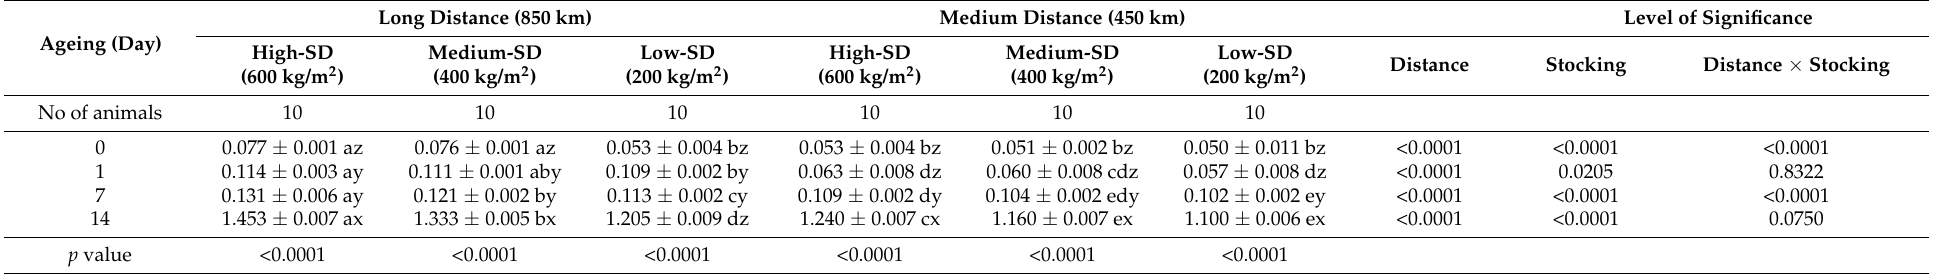
Table 4. Differences in the malondialdehyde content MDA (mg/kg) of Longissimus lumborum muscle during postmortem ageing periods in cattle subjected to different distances and stocking densities during road